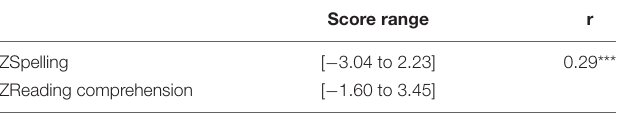
TABLE 4 | Descriptive statistics of individual difference